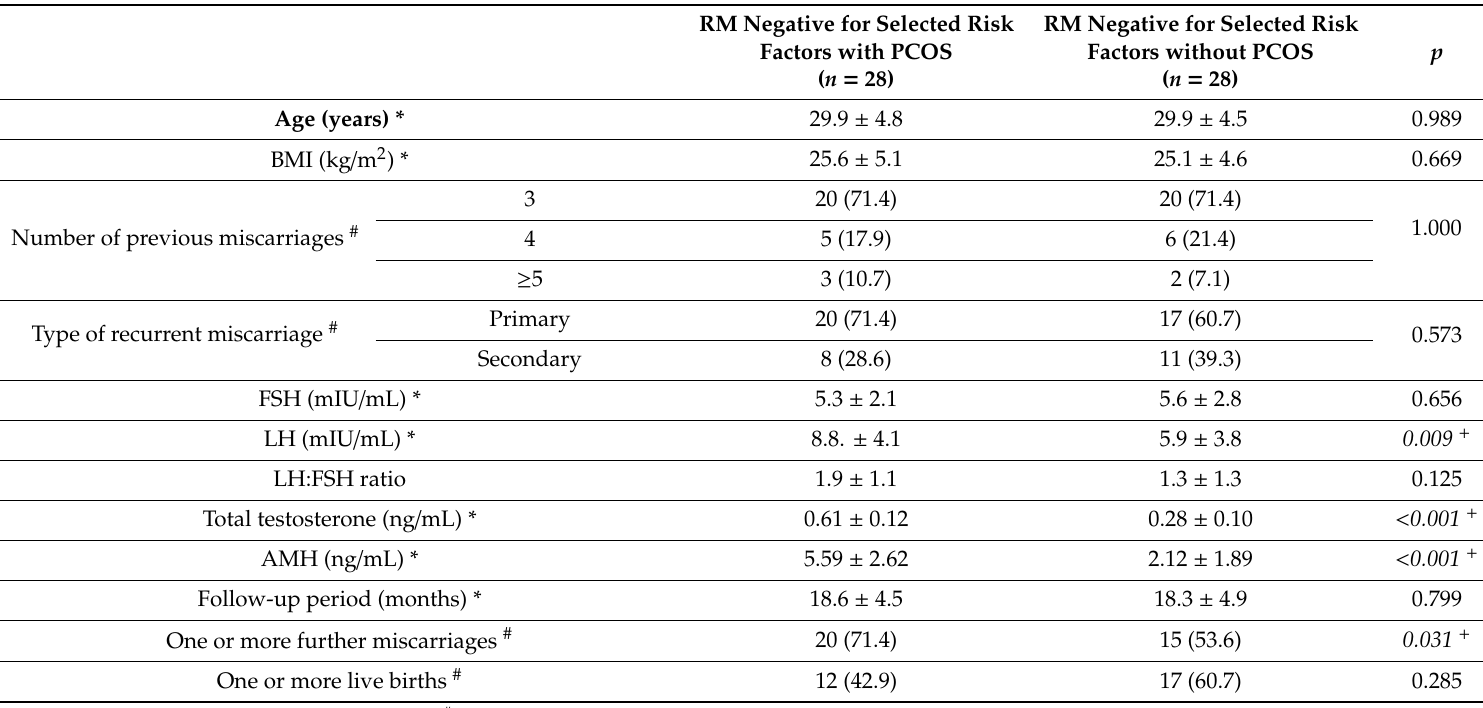
Table 3. Basic patient characteristics and further pregnancy outcome in women with RM negative for selected risk factors with and without PCOS (retrospective cohort).